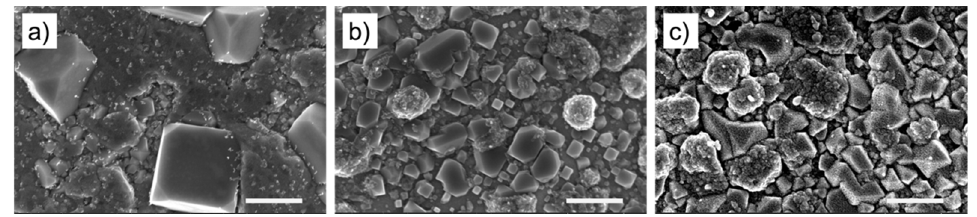
Figure 2. Scanning electron microscope (SEM) images of ( a ) Cu-Ni electrode before the two-step annealing process, ( b ) Cu-Ni electrode after the two-step annealing, ( c ) PBS-treated Cu-Ni (PBS-Cu- Ni) electrode. Scale bar: 500 nm.